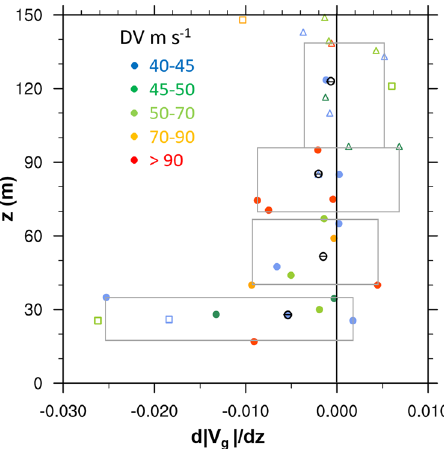
Fig. 3 Median and all samples of slope of DOW-observed tornado windspeeds d|V g |/dz|. Normalizations based on V g observed at lowest level in each pro fi le. Icon colors represent tornado vortex intensity, DV, at lowest level in each pro fi le. Hollow triangles represent values with dz >50 m. Hollow squares represent values with nearly identical radar beam elevations which are excluded from medians. Black circles are seven- sample medians of d|V g |/dz| plotted at the mean z of the seven samples. Gray boxes outline d|V g |/dz| and z spread of all values in each median.